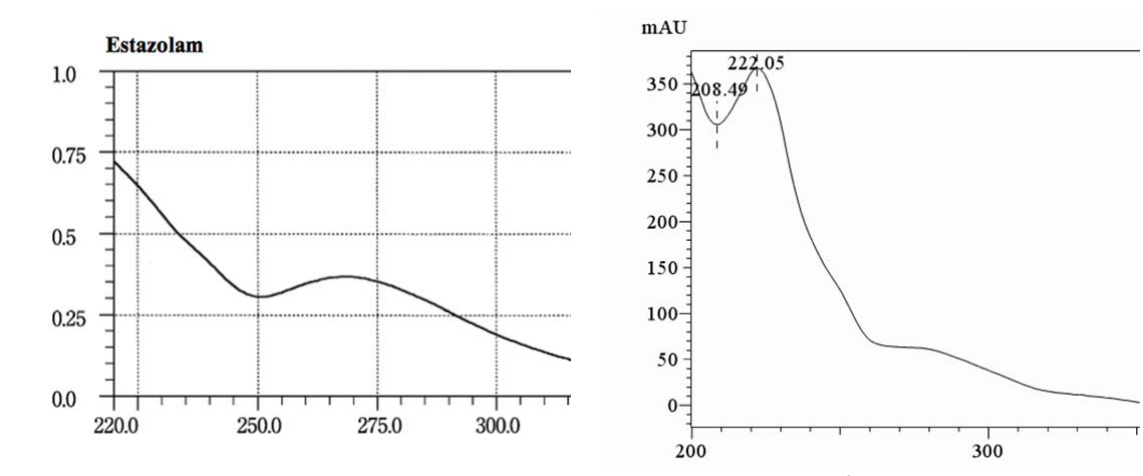
Fig. 3. Estazolam absorbance spectrum: a – obtained by measurement with DAD detector; b – obtained from Japanese